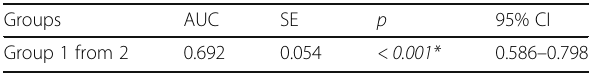
Table 5 Diagnostic performance of RRI in prediction of